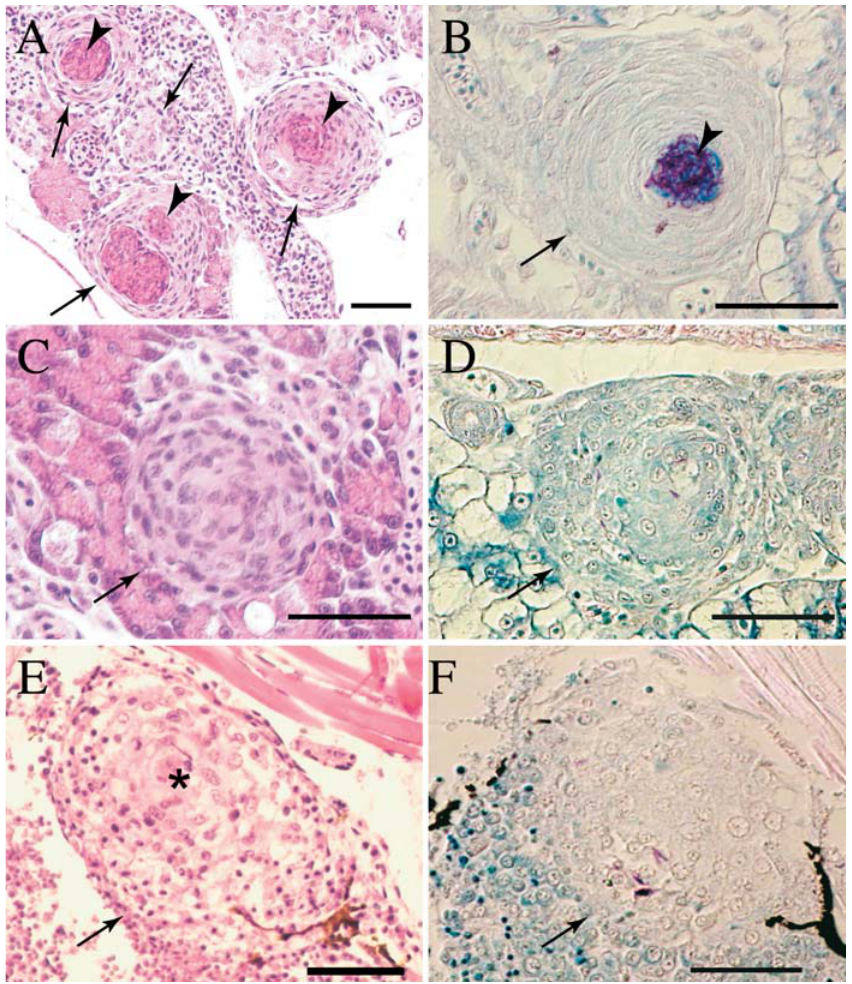
Figure 10. D RD1 Infection Is Associated with Persistent Defects in Granuloma